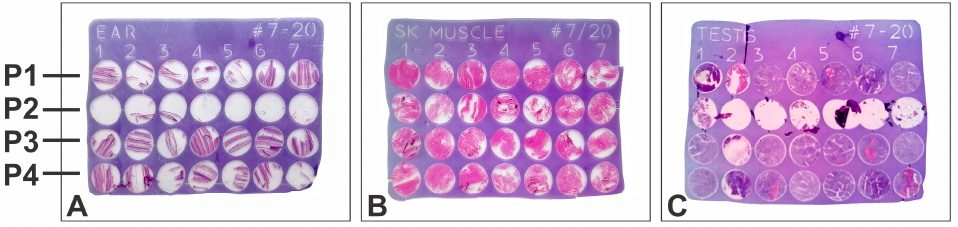
Figure 6. Tissue microarray, hematoxylin-eosin slide: ( A ) ear; ( B ) skeletal muscle; ( C ) testes; P1–P4: tissue processing protocols.